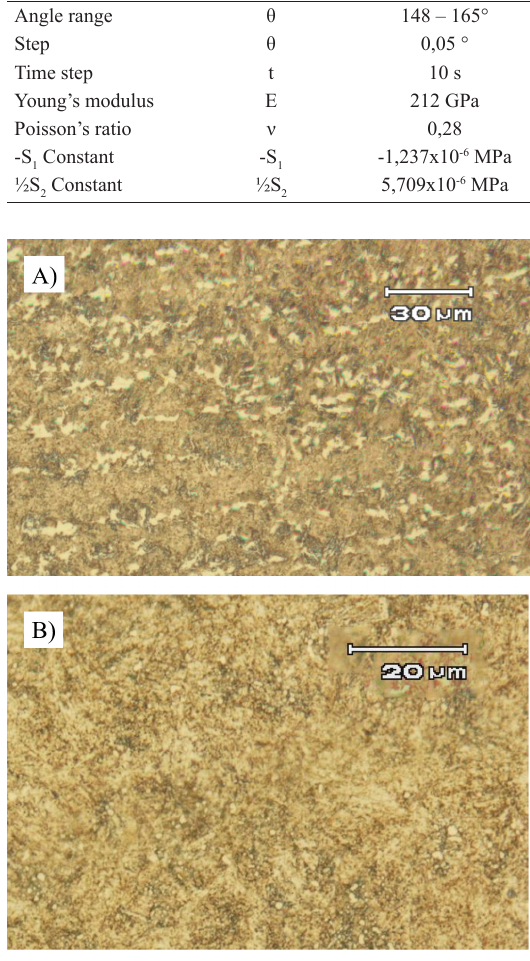
Figure 2. Microstructure of samples in conditions: a) HR (uncoiled and straightened); and b) GR (uncoiled, straightened, austempered, tempered, and surface finished). Images obtained from optical microscopy and etching with Nital 2%.